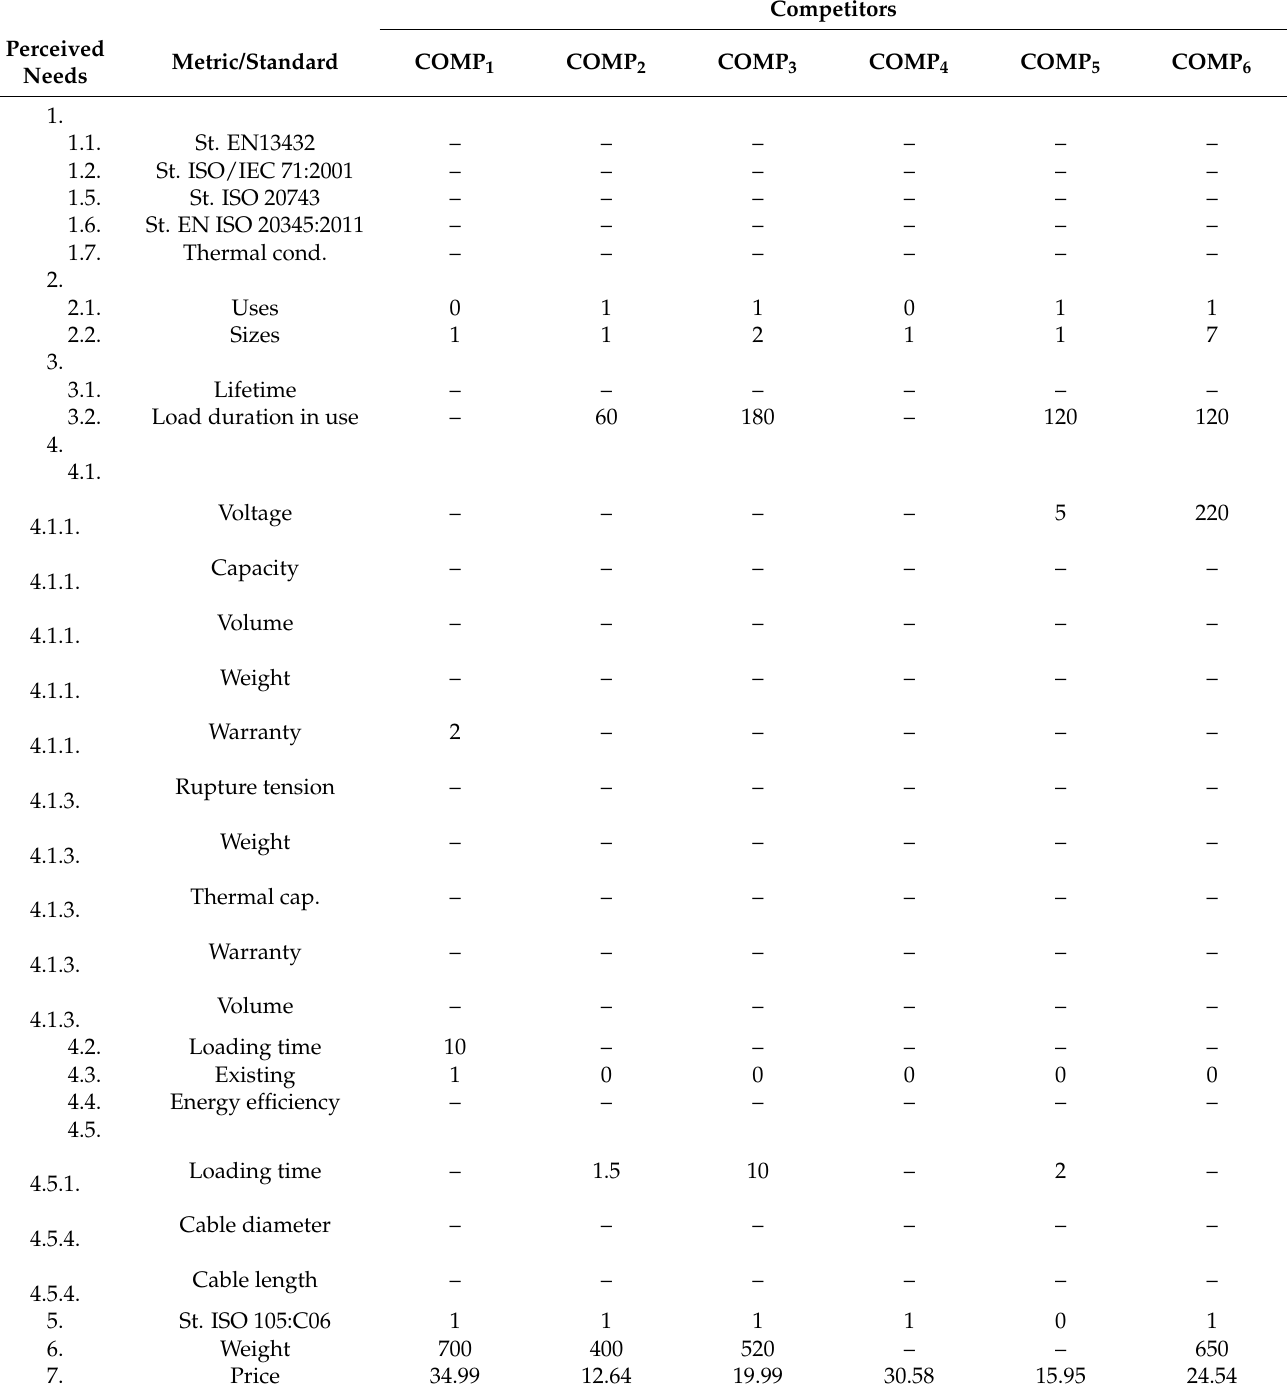
Table 6. Results of benchmarking analysis of potential competing